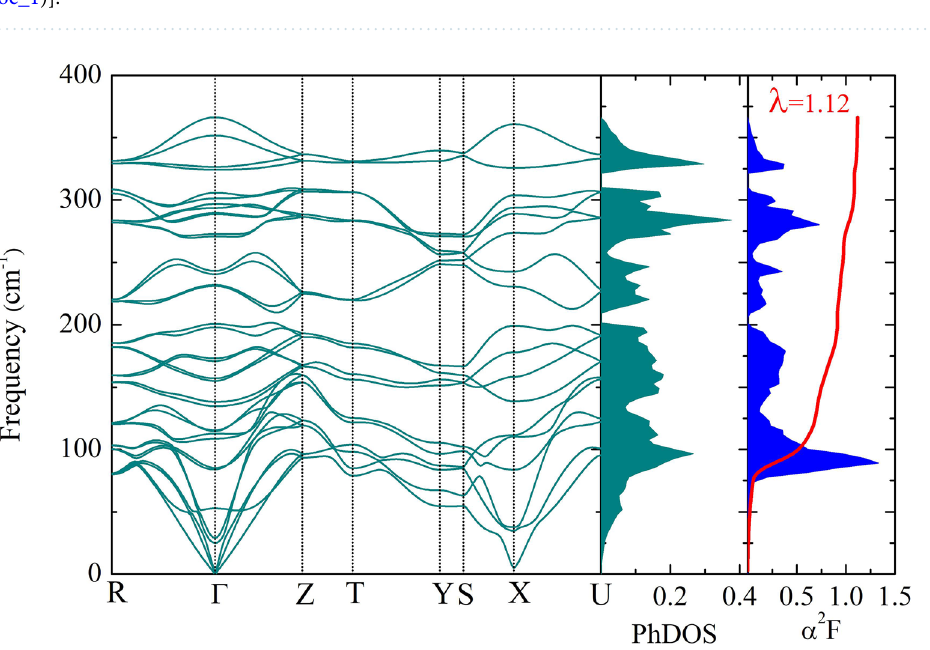
Figure 3. The phonon dispersion of Nb(Se 0.5 S 0.5 ) 2 structure, the phonon density of state of Nb(Se 0.5 S 0.5 ) 2 structure and Eliashberg spectral function of Nb(Se 0.5 S 0.5 ) 2 structure,